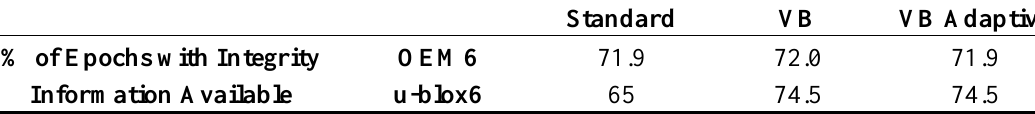
Table 5. Availability of GNSS integrity information—natural